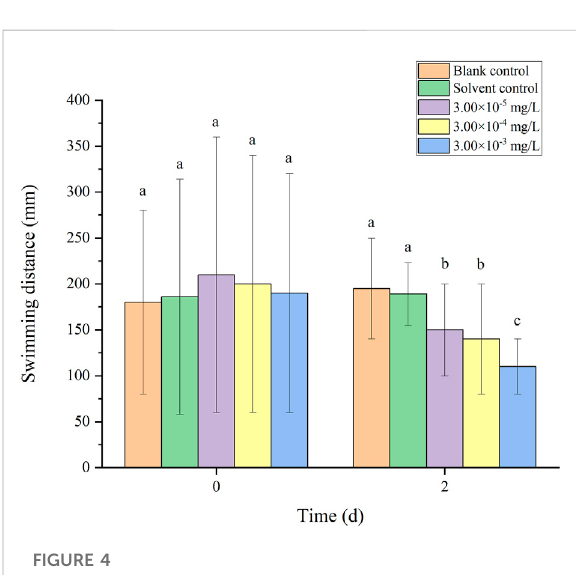
FIGURE 4 Effects of fenvalerate on the swimming distance of zebra fi sh larvae locomotion.